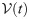
U-turn dynamics in groups of N = 5 fish.We depict here the temporal dynamics for the average velocity, average polarization, number of influential neighbors and its variation in over 475 experimental (blue) and 1000 artificial (red) recordings of collective U-turns. (A) Average speed V(t). (B) Average group polarization P(t). (C) Average number of influential neighbor N(t) per focal fish. (D) Average of the absolute variation in the number of influential neighbors |ΔNif| divided by the number of influential neighbors Nif, defined in Eq (5): 〈η(t)〉. Horizontal axis denotes normalized time t¯, where ts and te denote the start and end of the collective U-turn respectively. The procedure to construct the artificial observations is presented later and in the section “Null model” in Materials and Methods.